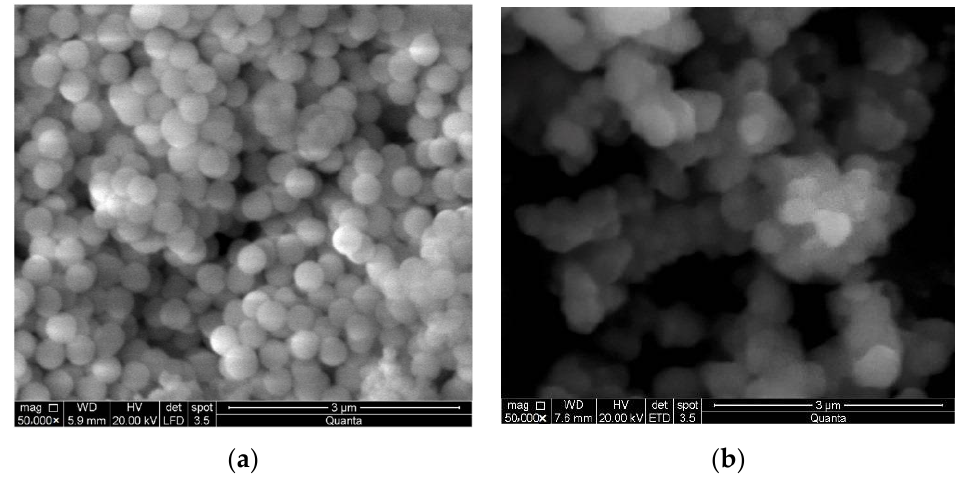
( a ) ( b ) Figure 9. SEM pictures of fresh ( a ) and recovered nanosilica ( b ) with magnification of × 50,000. The main polyol properties regarding the foaming process are hydroxyl number, functionality and average molecular weight. The hydroxyl number was measured as described previously (Section 2.4.3). The average molecular weight was calculated from GPC analysis and the functionality using Equation (3).